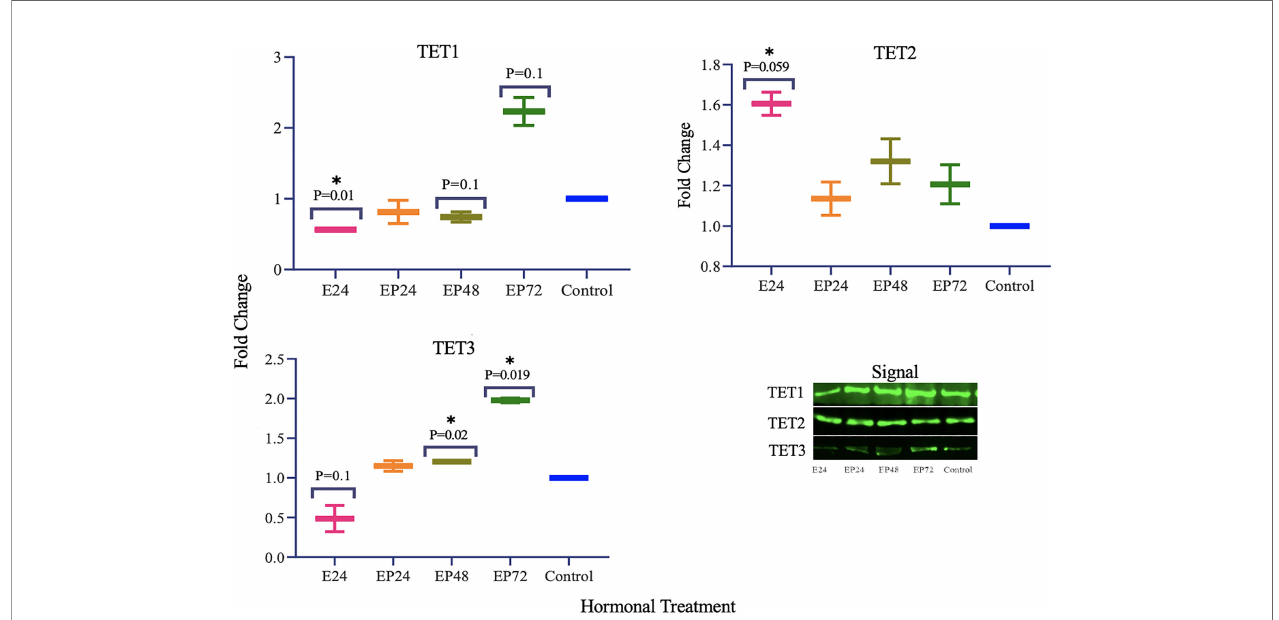
FIGURE 5 | TET protein expression in response to different steroid hormone treatments in RL95-2 cells. A representative blot image for the particular weight band is shown next to the graph. The y-axis shows the fold change of protein levels following different treatments compared to control and x-axis shows the different treatment groups. E24 = 24h Estrogen; EP24, EP48 and EP72 = both Estrogen + Progesterone for 24, 48 and 72h. Data are presented as mean ± SEM, *p < 0.05, P ≤ 0.1 is considered as approaching signi fi cance. The experimental setup included three independent sets of cell culture experiments (n =3) with three technical replicates for each sample.